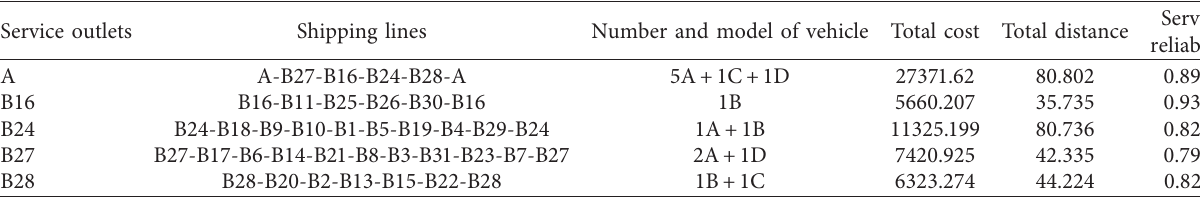
Table 9: Cold chain transport path, distance, cost, and service reliability in a dynamic environment.